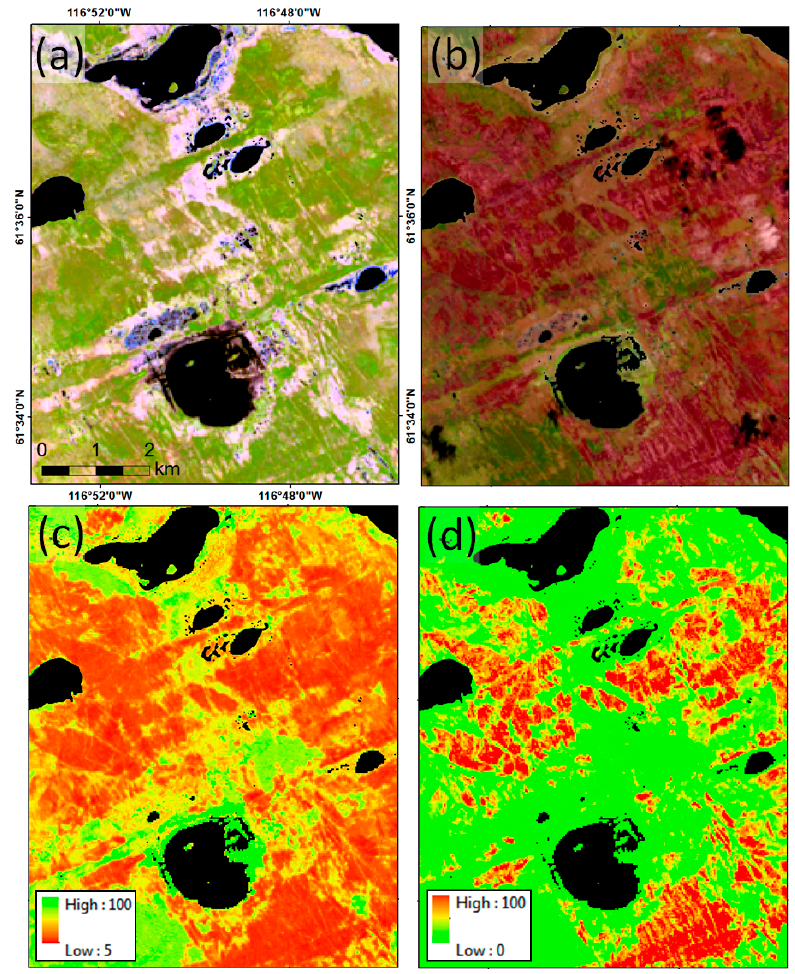
Figure 7. A 60 km 2 area within our study region captured using ( a ) pre-burn Landsat-8 imagery from 17 July 2013; and ( b ) post-burn Landsat-8 imagery from 23 July 2015 (RGB = SWIR, NIR, Red); Predictions of percent post-burn green vegetation cover and percent charred surface cover, based on UAV calibration of Landsat burn indices, are shown respectively in ( c , d ).